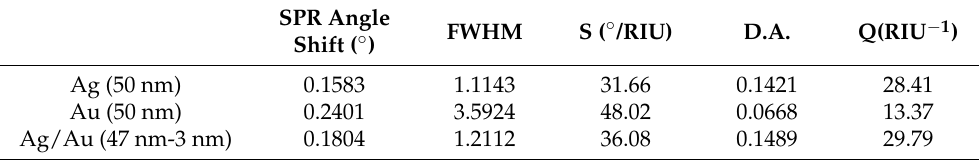
Table 2. Performance comparison of the sensor with single-layer metal and double-layer